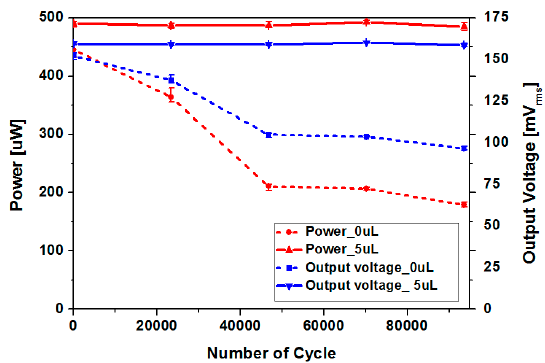
Figure 15. Output power and voltage variation during cyclic testing (input acceleration: 3 g, input frequency: 13 Hz).